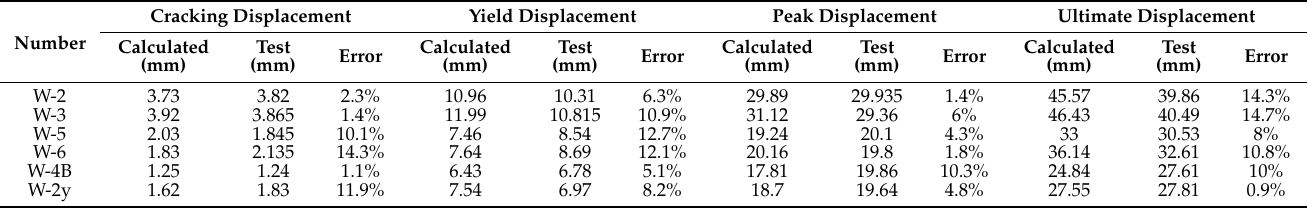
Table 1. Comparison of calculated displacement and test displacement.